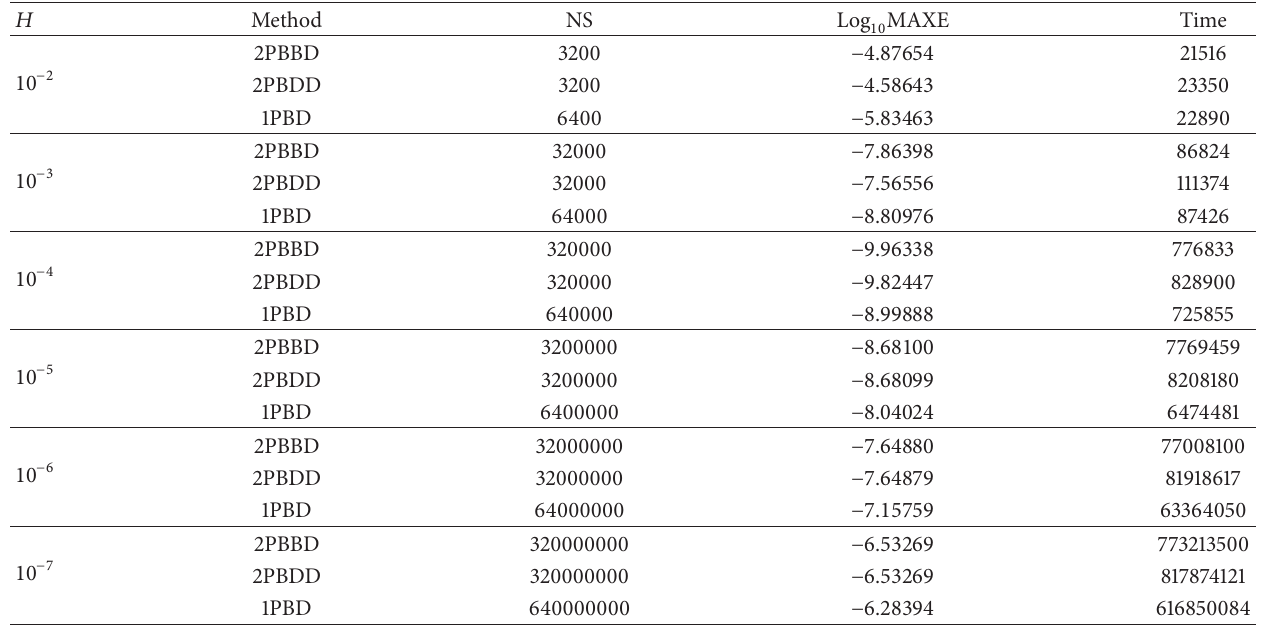
Table 5: Numerical result for Problem